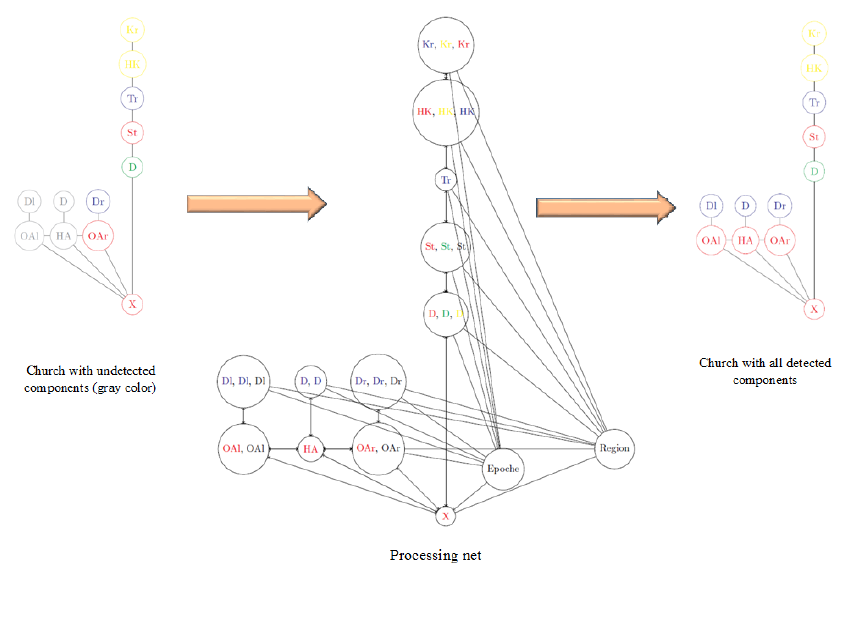
Figure 3: Processing principle.